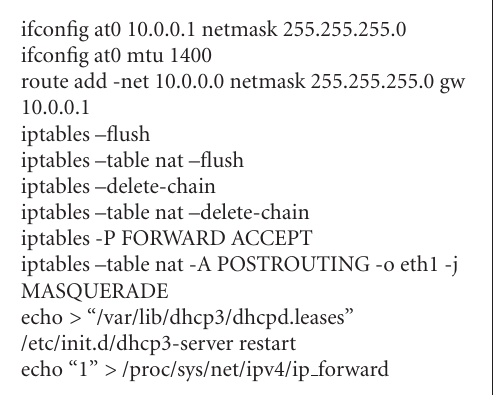
Algorithm 4: IPtable code to provide Internet access for the vic-